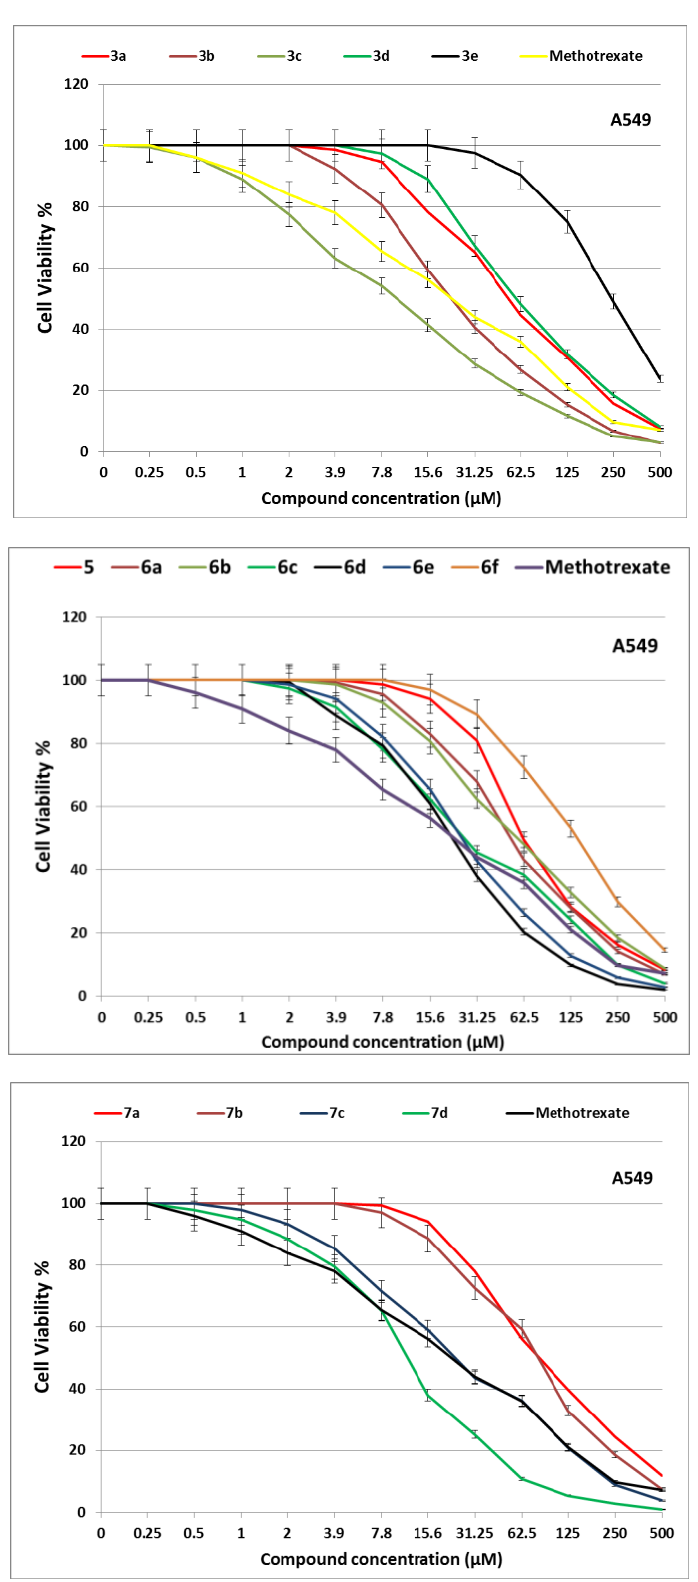
Figure 2. Growth inhibition curves showing the human Lung adenocarcinoma (A549) cell line treated with the tested compounds at different concentrations compared to the reference drug methotrexate.